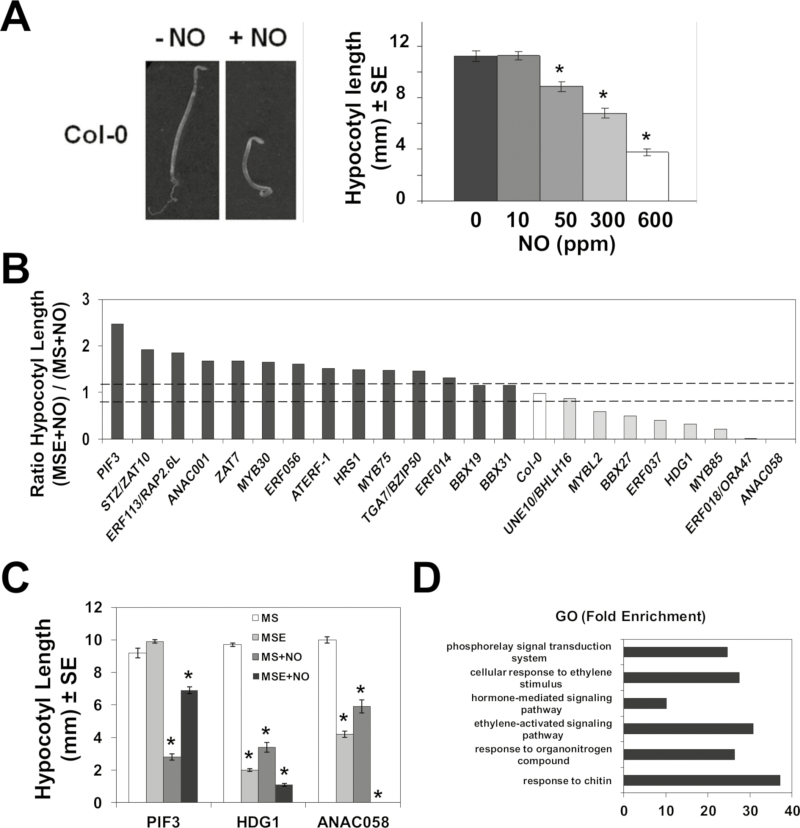
Screening of TPT transgenic lines conditionally expressing transcription factor-encoding genes through an NO-triggered hypocotyl shortening in etiolated seedlings. (A) NO triggers a dose-dependent hypocotyl shortening. (B) Ratio of the hypocotyl lengths in TPT lines exposed to NO in the absence (MS) or presence of the inducer β-estradiol (MSE). Dashed lines represent the upper and lower variability limits of the ratios of wild-type Col-0 hypocotyl lengths. (C) Hypocotyl lengths of TPT lines expressing PIF3, HDG1, and ANAC058 transcription factors are altered by β-estradiol treatment even in the absence of NO. (D) Gene Ontology (GO) analysis points to a significant enrichment of the hormone and organonitrogen compound categories among genes triggering significant hypo- or hypersensitivity to NO in the screening of TPT lines. *P-values <0.05 in Student’s t-test.